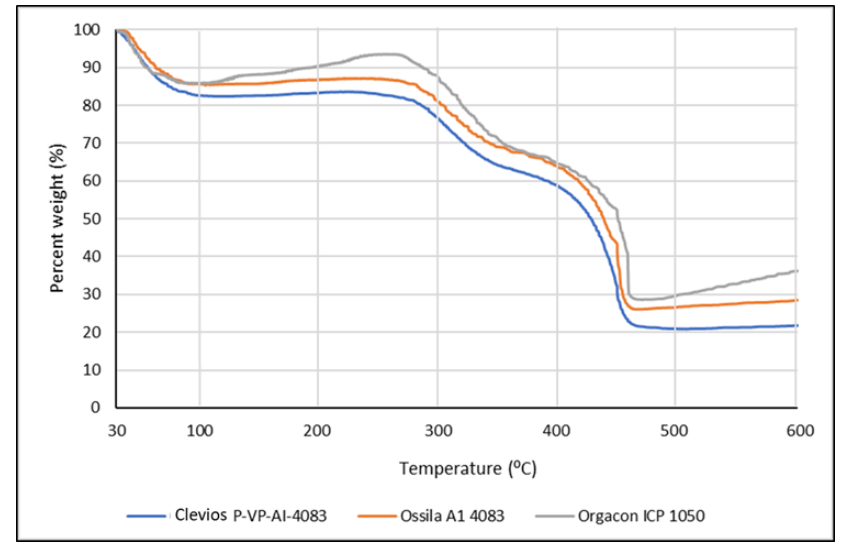
Figure 6. TGA Curves of Clevios, Ossila, and Orgacon PEDOT:PSS.